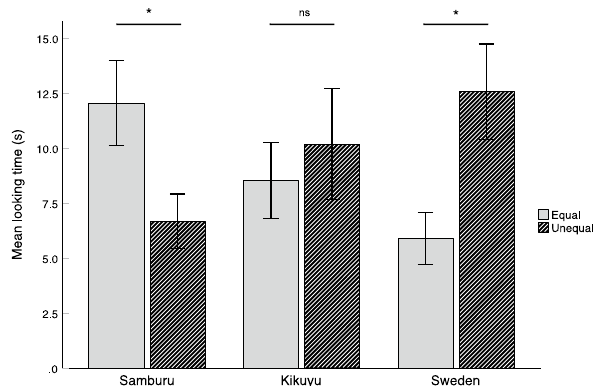
Figure 2. Mean looking times to the equal and unequal distribution conditions for each group and condition. Error bars show standard errors of the mean. Asterisks denote significant differences between conditions ( p < 0.05,